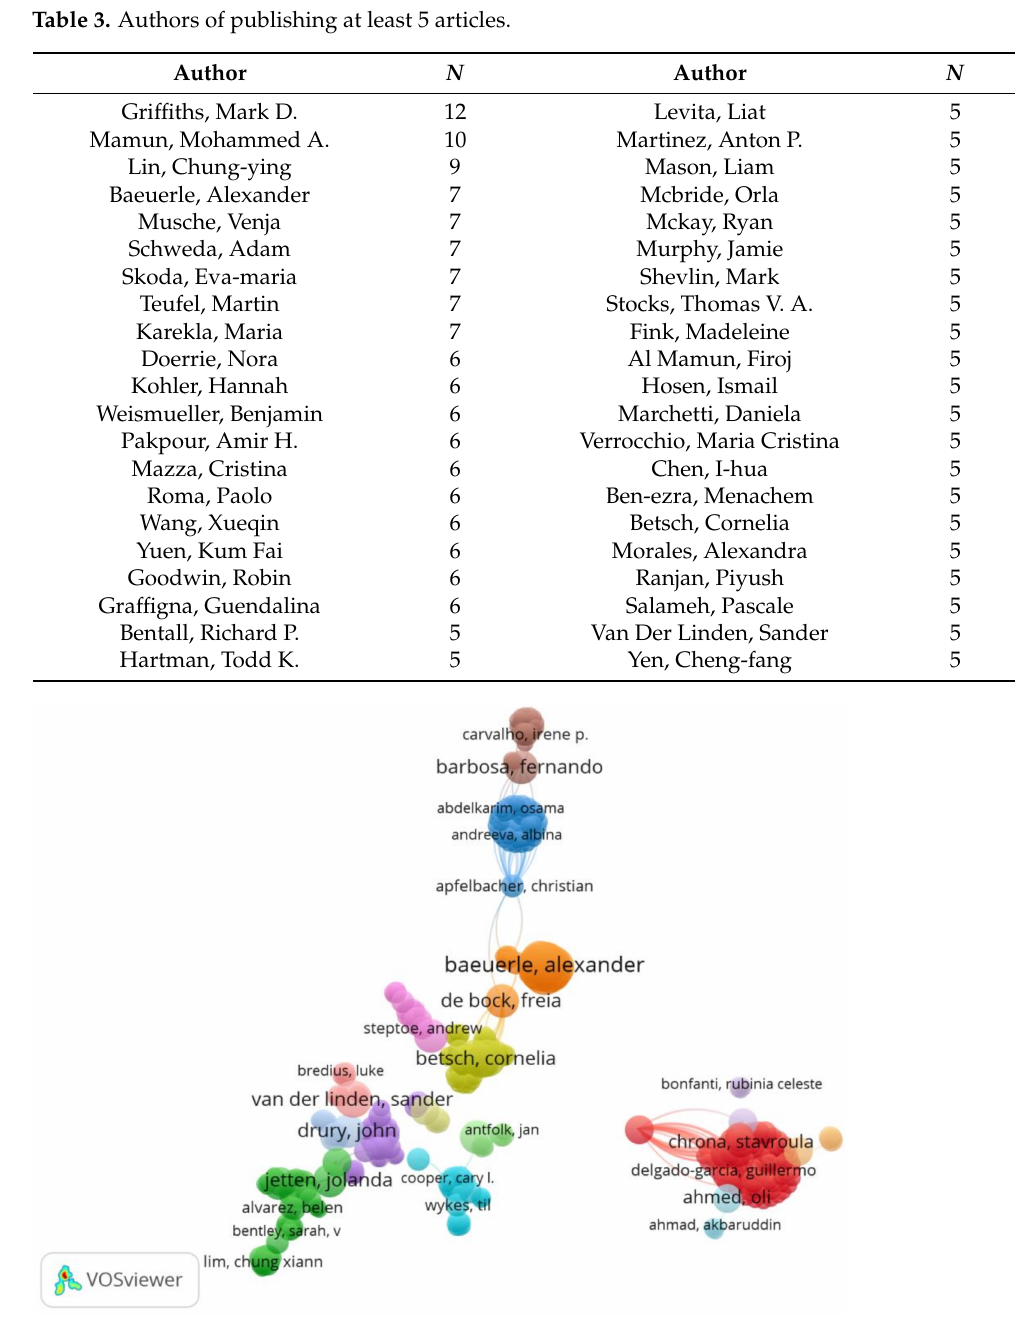
Figure 2. Network map of author collaboration